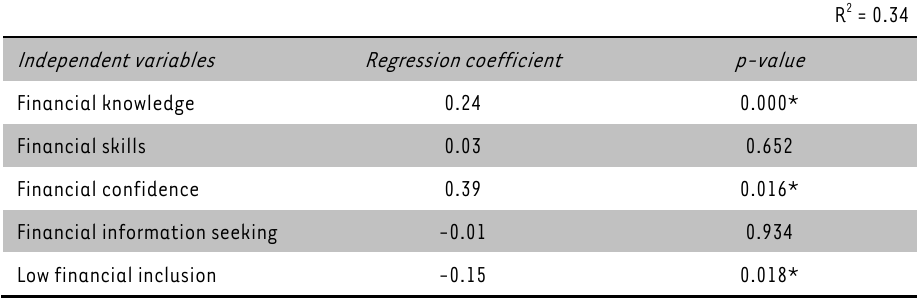
TABLE 4: Multiple regression analysis results for the influence of the independent variables on the dependent variable responsible spending